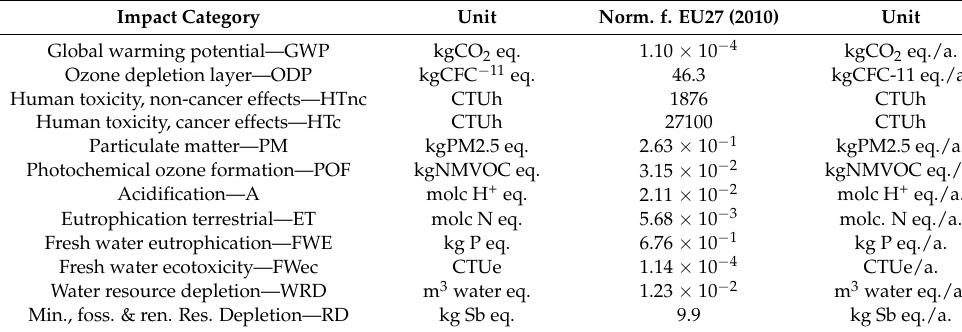
Table 3. Impact categories and normalization